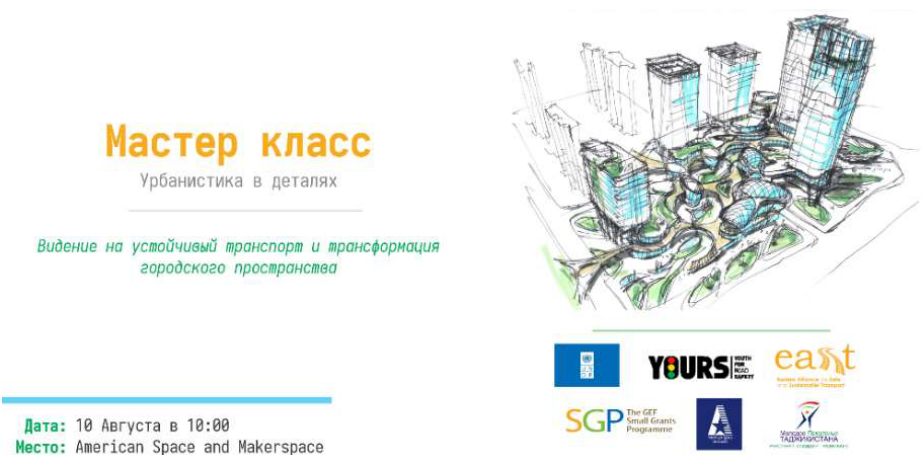
Figure 5. An online workshop flyer designed and disseminated by the Young Generation of Tajikistan (courtesy of the Young Generation of Tajikistan).